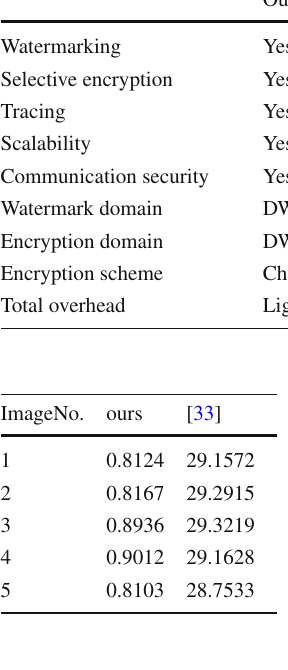
Table 5 Comparisons of the Related Schemes